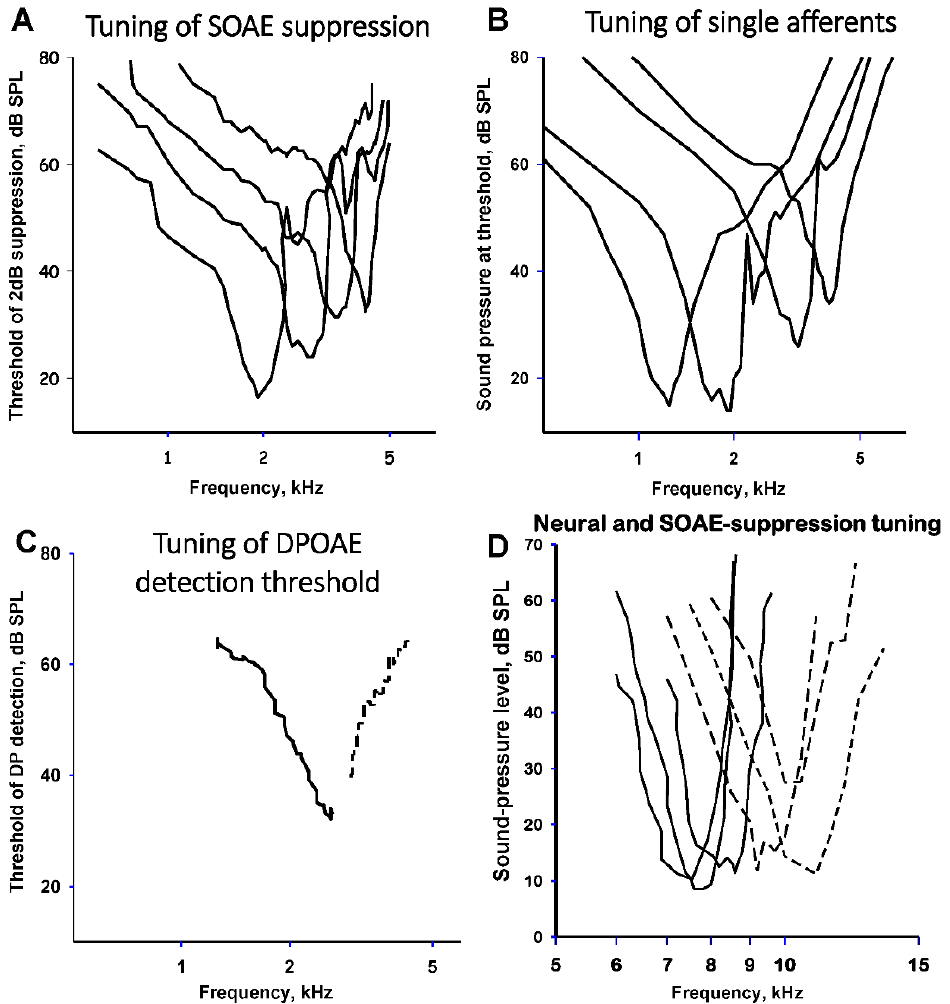
Figure 3. A comparison of different measures of frequency selectivity tuning in ( A ) the suppression of four SOAE, ( B ) threshold tuning of four single auditory-nerve fibers, ( C ) DPOAE detection thresholds for 2f1 − f2 (continuous line) and 2f2 − f1 (dashed line) in the Bobtail skink Tiliqua rugosa, and ( D ) three single auditory nerve fiber tuning curves (continuous lines) and suppression of three SOAE peaks (dashed lines) in the barn owl Tyto alba .